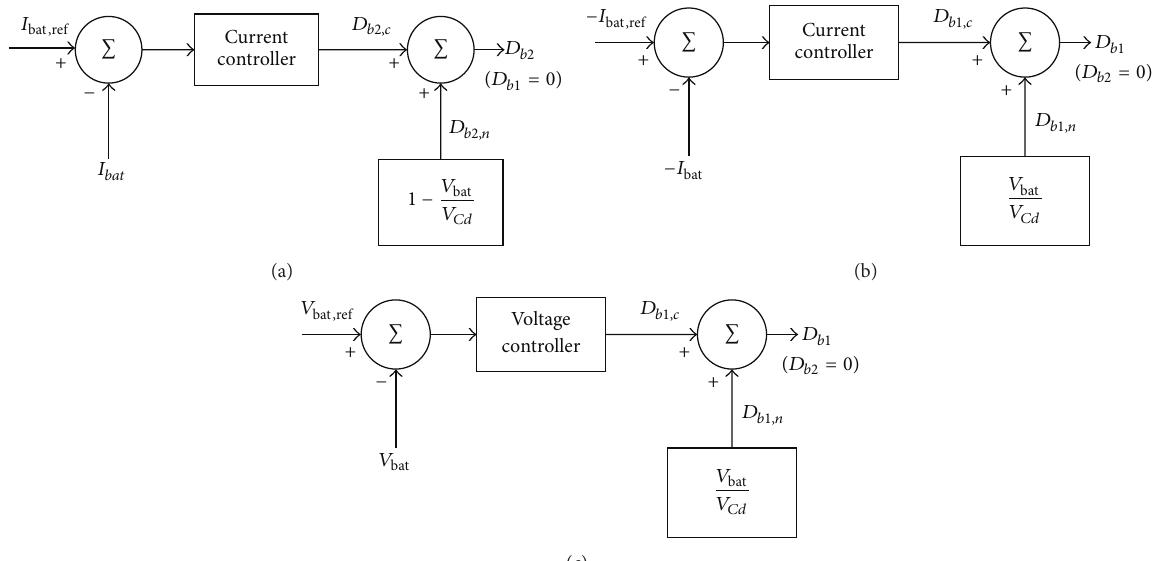
Figure 6: Control-block diagrams of the battery charger/discharger; (a) battery discharging control; (b) battery charging control with current control; (c) battery charging control with voltage